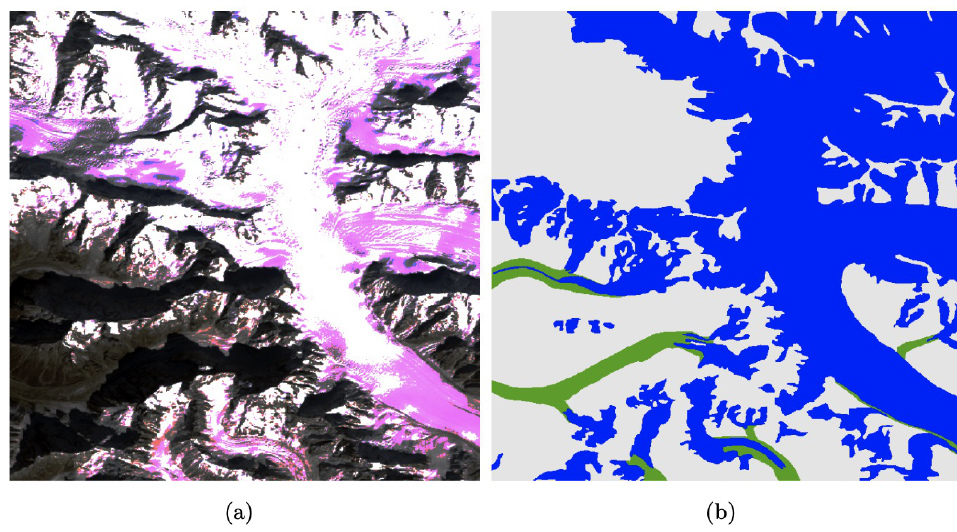
Figure 3. ( a ) An example of the preprocessed patch. ( b ) Corresponding mask patch. In the prepro- cessed patch, target glaciers now make up a large proportion. The pink areas are a consequence of feature equalization. They tend to represent the clean ice glaciers. As noted in the main text, equaliza- tion makes the color channel values more condensed, and these distortions lead to images that differ from the typical RGB views. We further discuss the relationship between feature equalization and image color in the